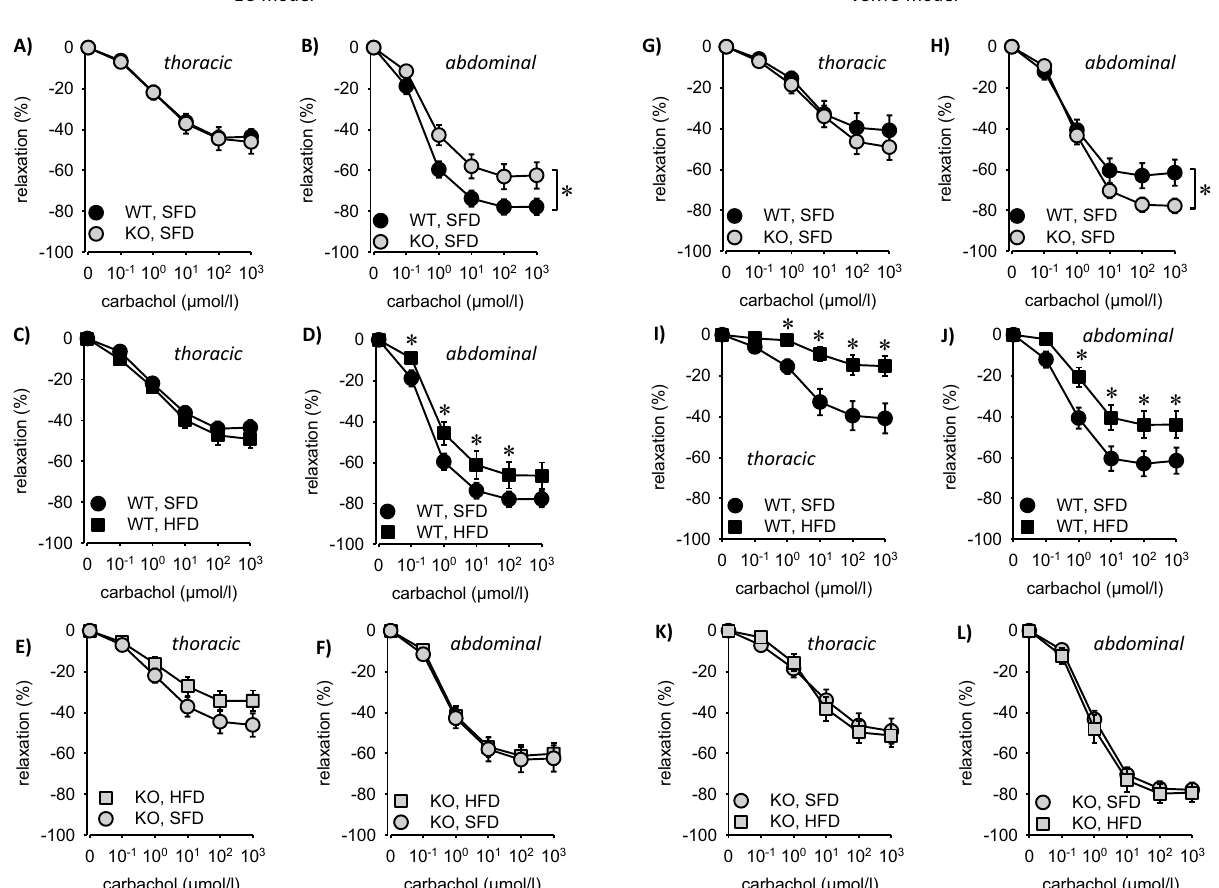
Figure 3. ( A , B ) Isometric relaxation of thoracic and abdominal aortic rings of EC-EGFR-KO and EC-EGFR-KO under SFD in response to carbachol. ( C – F ) Effect of HFD on isometric relaxation of thoracic ( C , E ) and abdominal ( D , F ) aortic rings in response to carbachol in EC-EGFR-WT ( C , D ) and EC-EGFR-KO ( E , F ) animals. Number of animals N(WT, SFD) = 10, N(WT, HFD) = 8, N(KO, SFD) = 8, N(KO, HFD) = 11. ( G , H ) Isometric relaxation of thoracic and abdominal aortic rings of VSMC-EGFR-KO and VSMC-EGFR-KO under SFD in response to carbachol. ( I – L ) Effect of HFD on isometric relaxation of thoracic ( I , K ) and abdominal ( J , L ) aortic rings in response to carbachol in VSMC-EGFR-WT ( I , J ) and VSMC-EGFR-KO ( K , L ) animals. Number of animals N(WT, SFD) = 10, N(WT, HFD) = 8, N(KO, SFD) = 10, N(KO, HFD) = 10. *p < 0.05 versus respective control. SFD standard diet, HFD high fat diet, WT wildtype, KO knockout, EC endothelial cell, VSMC vascular smooth muscle